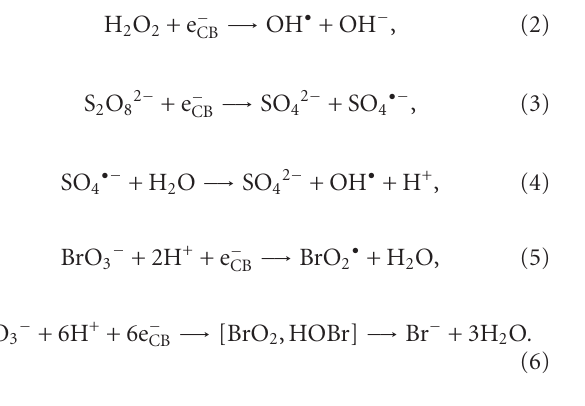
Figure 8: GCMS analysis of an irradiated Dinoseb in 1:1 acetonitrile/water mixture in the presence of TiO 2 for 8h. Inset shows GCMS analysis of Dinoseb before